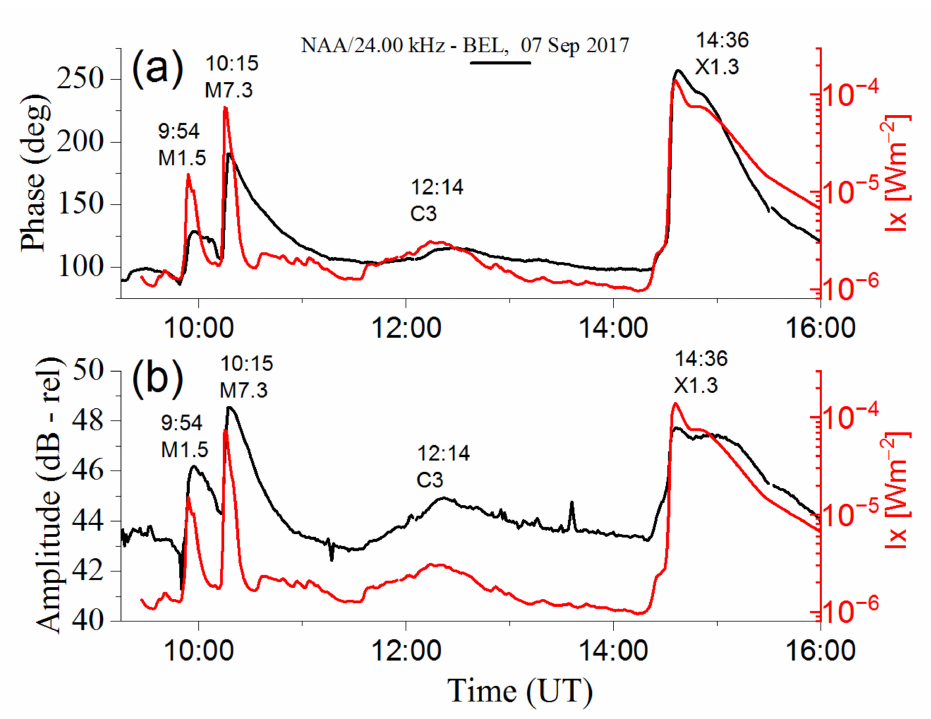
Figure 1. Time variation of X-ray irradiance on the right axes, NAA/24.00 kHz signal phase ( a ) and amplitude ( b ) during M1.5 (09:54 UT), M7.3 (10:15 UT), C3 (12:14 UT) and X1.3 (14:36 UT) events on 7 September